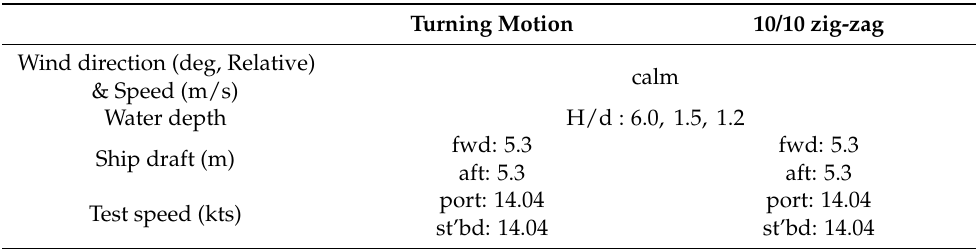
Table 9. Conditions for evaluating maneuverability in shallow